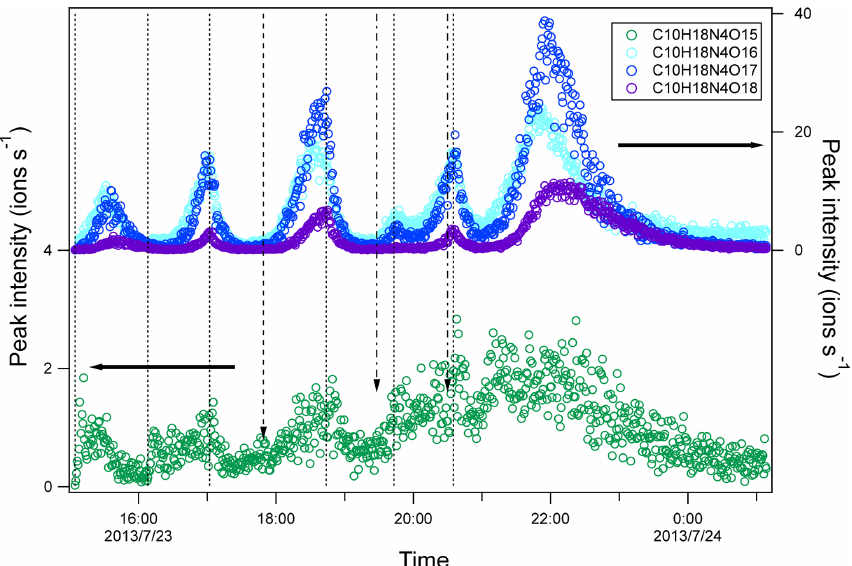
Figure 6. Time series of peak intensity of several HOM dimers of C 10 H 18 N 4 O n series. The dashed lines indicate the time of isoprene additions. The long-dashed arrow indicates the time of NO 2 addition. The dash-dotted arrows indicate the time of O 3 additions. The horizontal arrows indicate y -axis scales for different